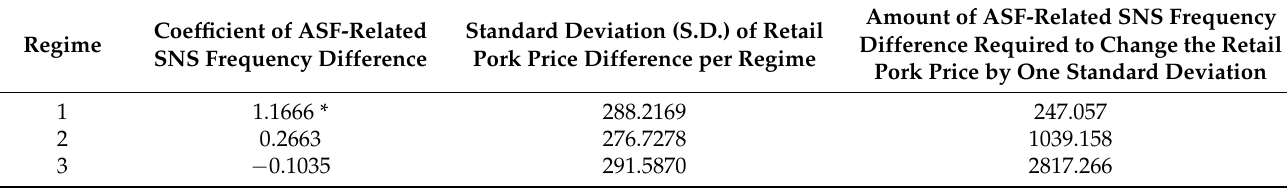
Table 4. Coefficients of African Swine Fever (ASF)-related SNS frequencies per regime and the amount of ASF-related SNS frequency difference required to change the retail pork price by one standard deviation.